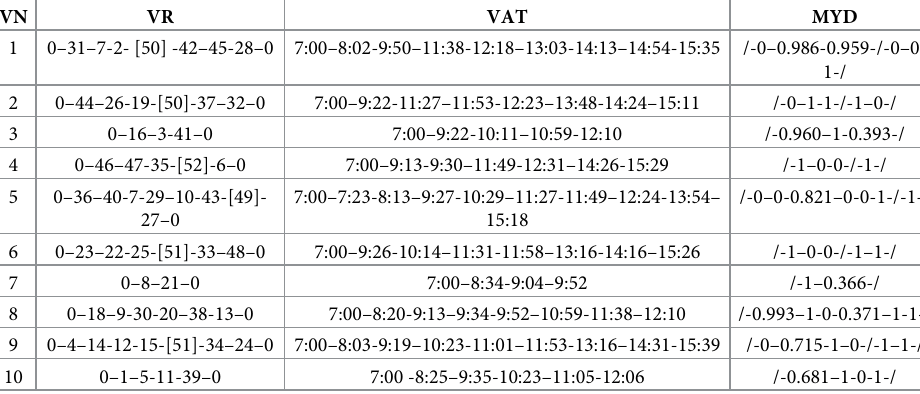
Table 10. NSGA-II optimal route distribution